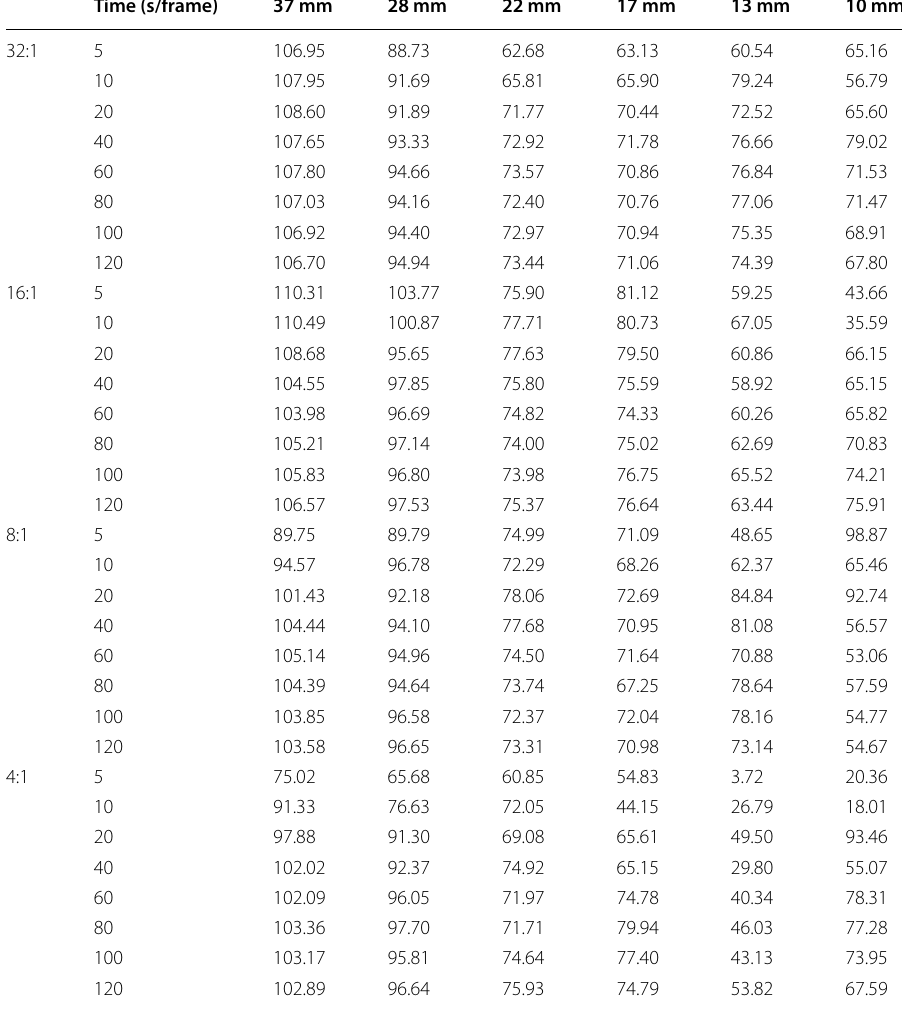
Table 6 RCs (%) of different acquisition